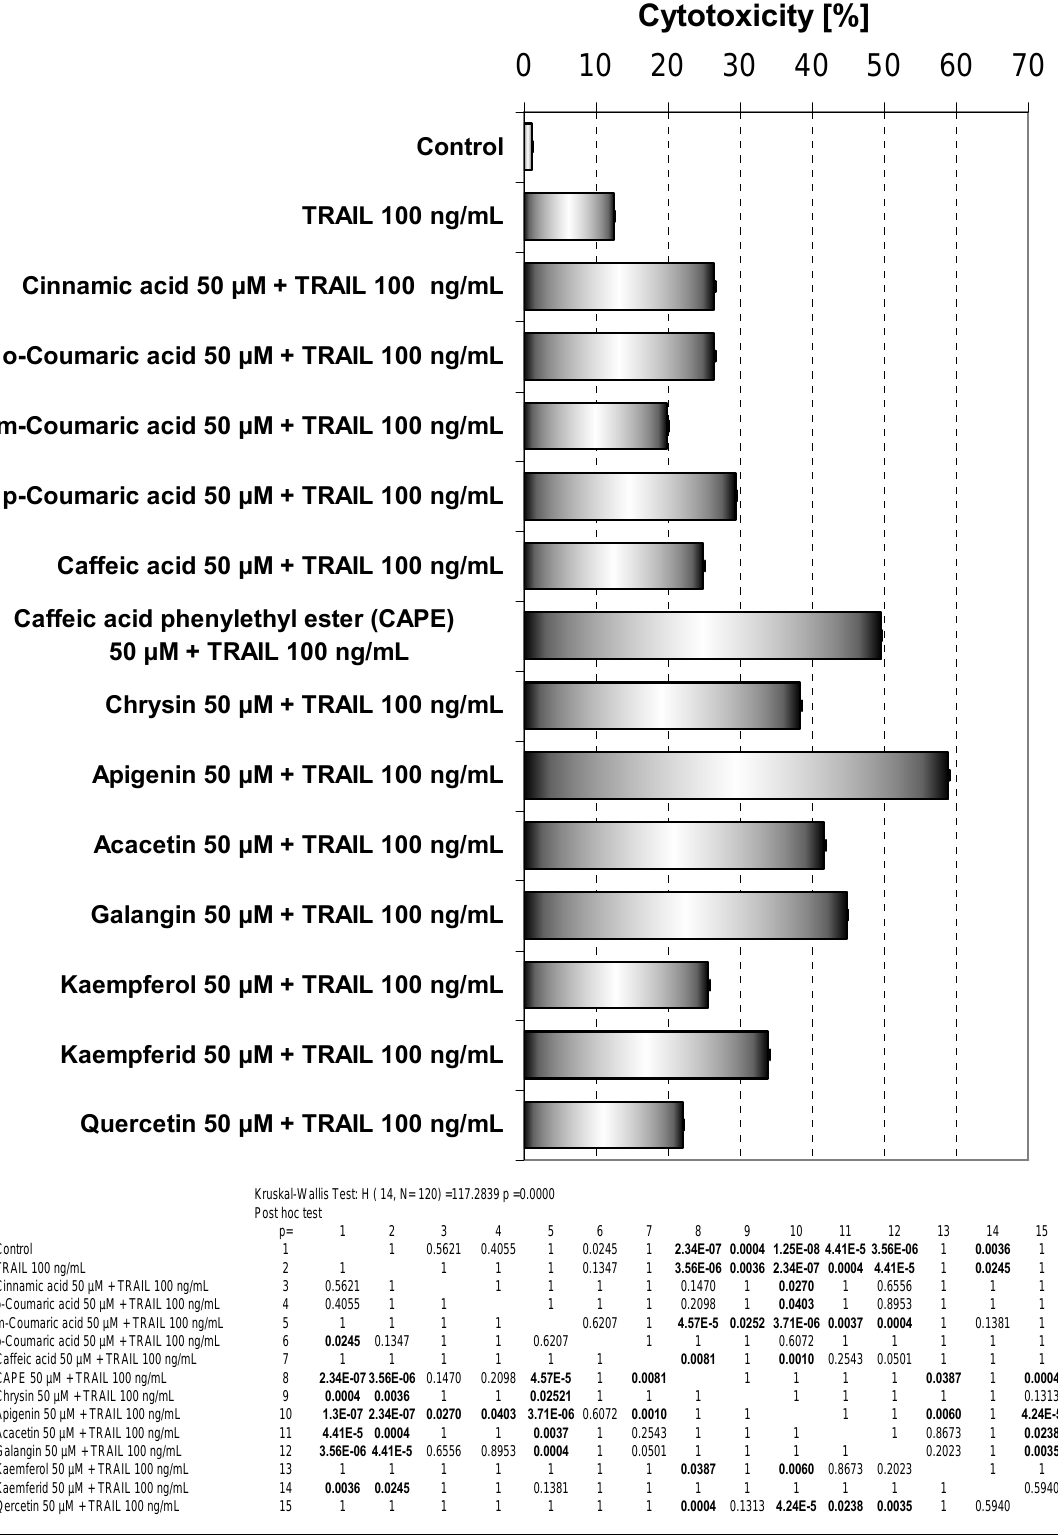
Figure 6. Cytotoxic activity of EEP phenolic components in combination with TRAIL in HeLa cells. The cancer cells were incubated for 48 hours with the compounds at the concentrations of 50 μ M and TRAIL at the concentrations of 100 ng/mL. The percentage of cell death was measured by MTT cytotoxicity assay. Cytotoxicity 0 10 20 30 40 50 60 70